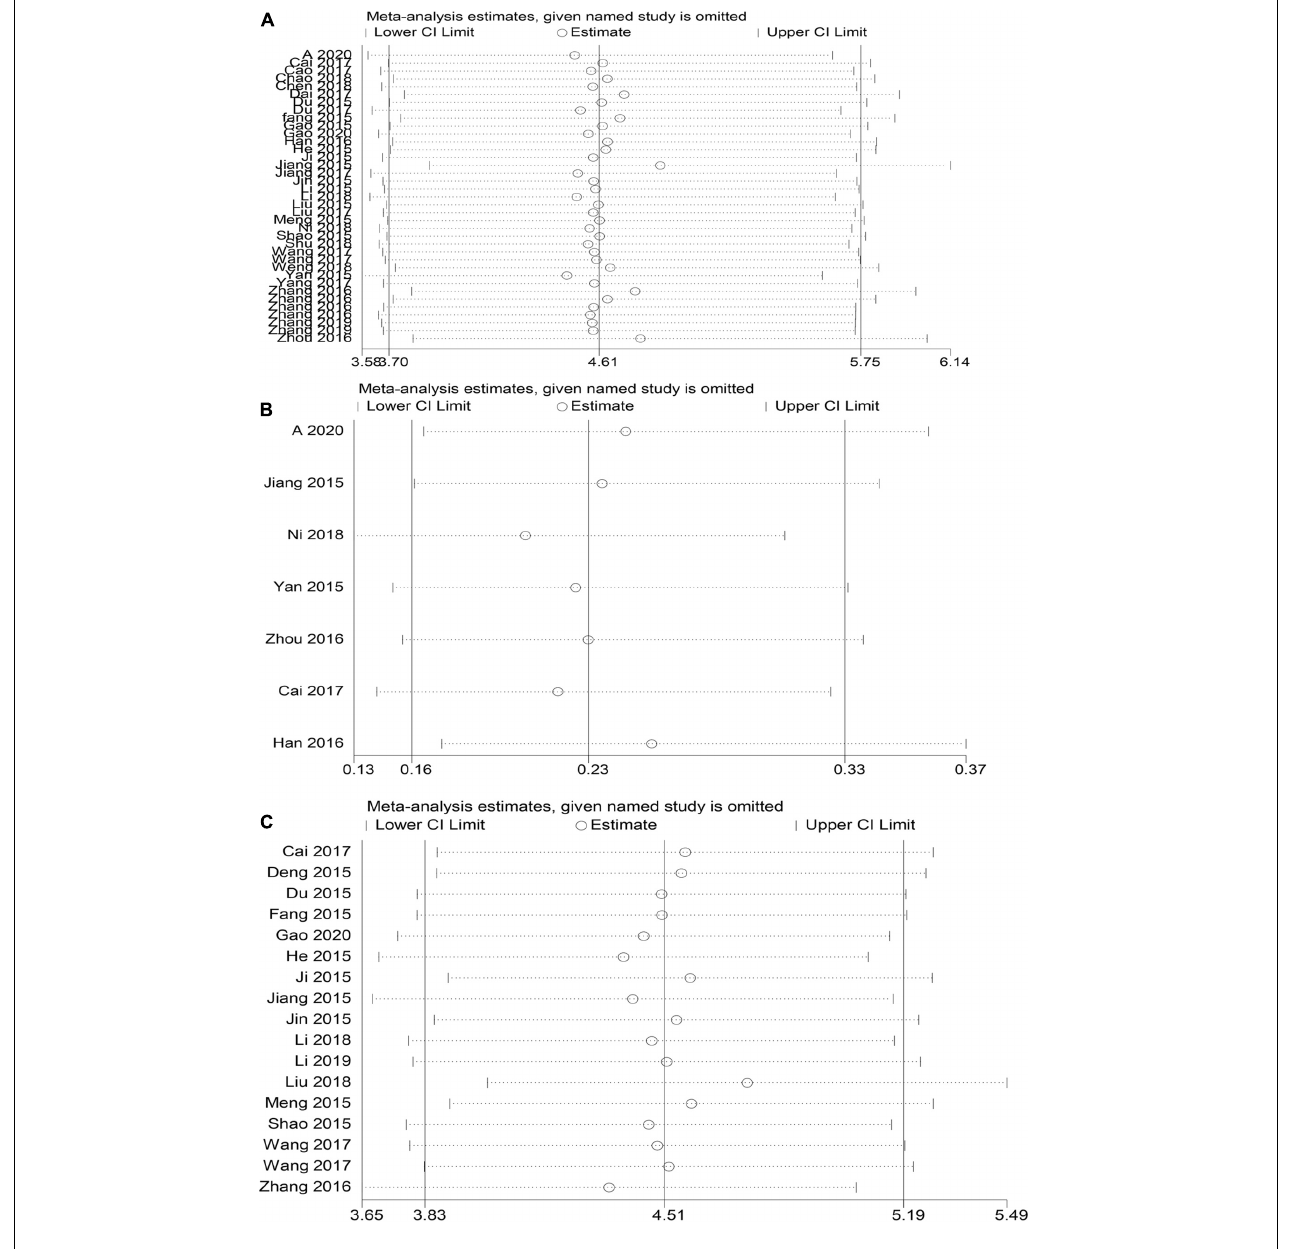
FIGURE 7 | HBOT and conventional treatment of neonates with HIE sensitivity analysis curve. (A) TEF, (B) risk of sequelae, (C) NBNA